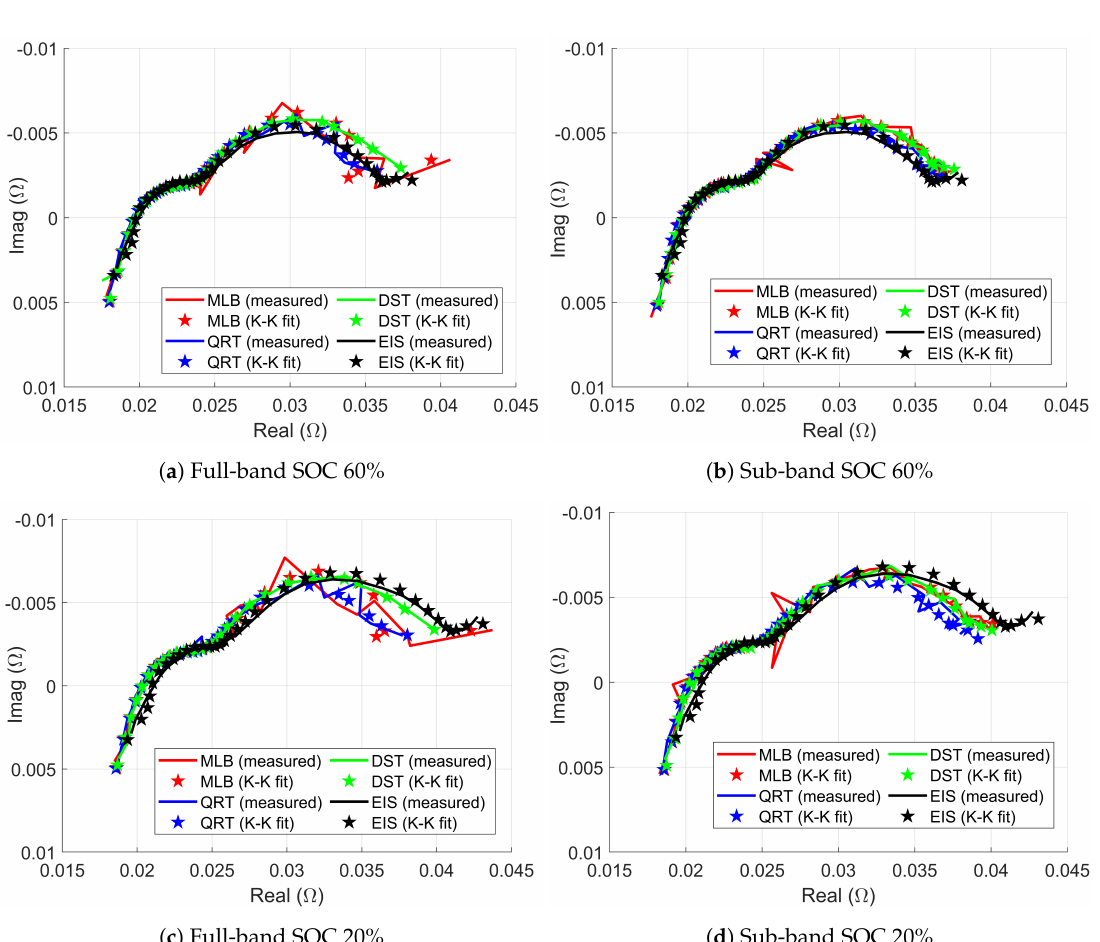
Figure 7. Measured and K–K fitted impedances from full-band and sub-band measurements at 20% and 60% of